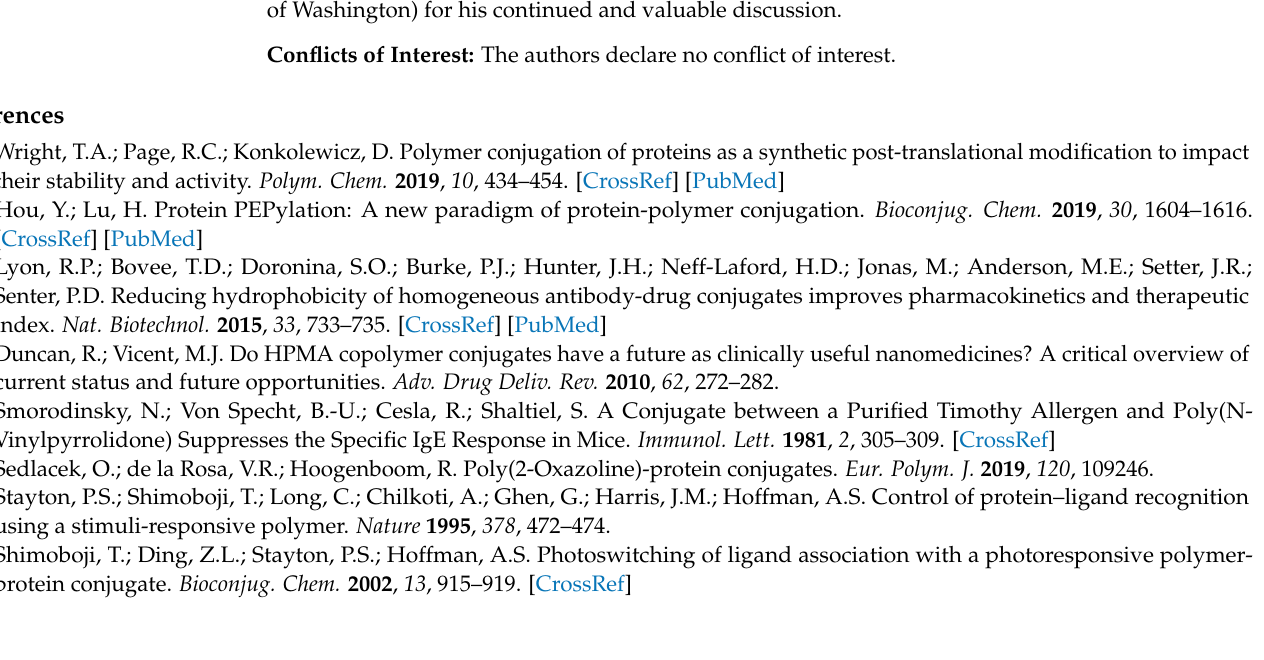
Table S2: The GPC results of each model reaction between NHS-CTA and monomer; Figure S3: DLS measurement result of IgG-CTA in PBS (0.1 mg/mL); Table S3: Value of each measurement by DLS and Zeta Potential; Figure S4: The thermal precipitation protocol of